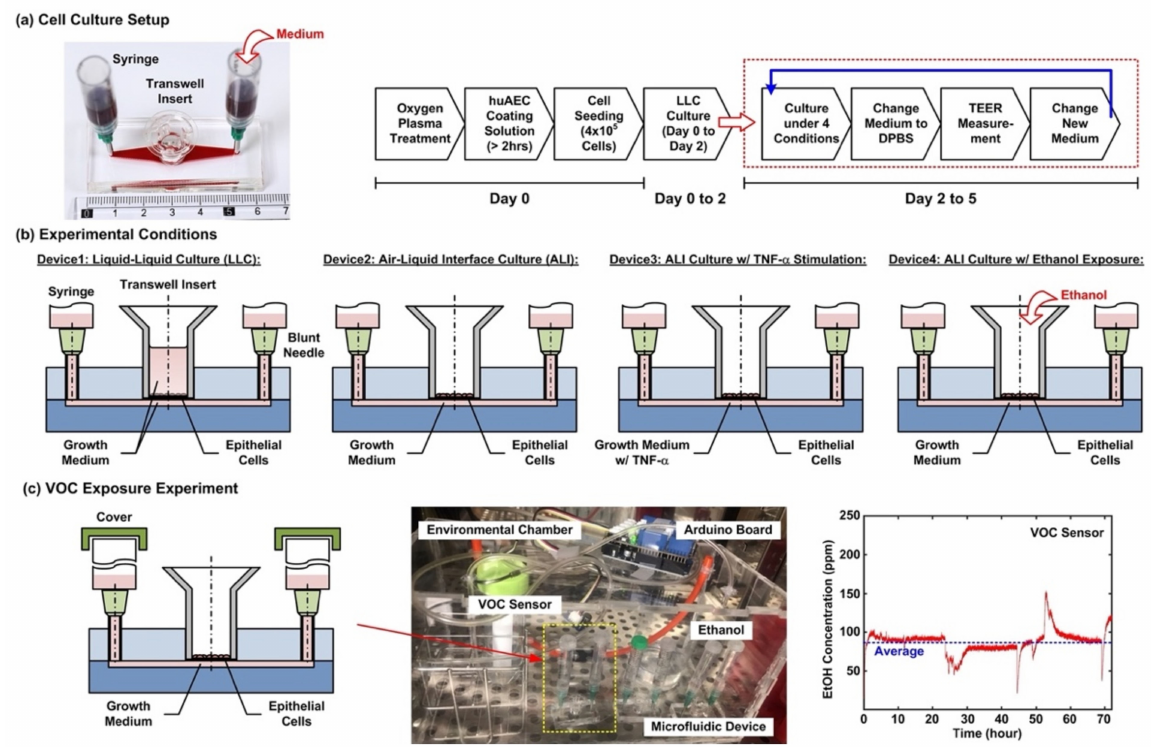
Figure 2. ( a ) Experimental photo of the cell culture setup, and an illustration of the cell culture experimental flow in the microfluidic device. ( b ) Four cell culture conditions tested in the experiments to study time-lapse trans-epithelial electrical resistance (TEER) variation of the epithelium cultured in different formats and under the cytokine and VOC exposure stimulations. ( c ) Schematic and photo of the experimental setup to perform the VOC (ethanol) exposure experiments on the developed transwell-embedded microfluidic device in a cell